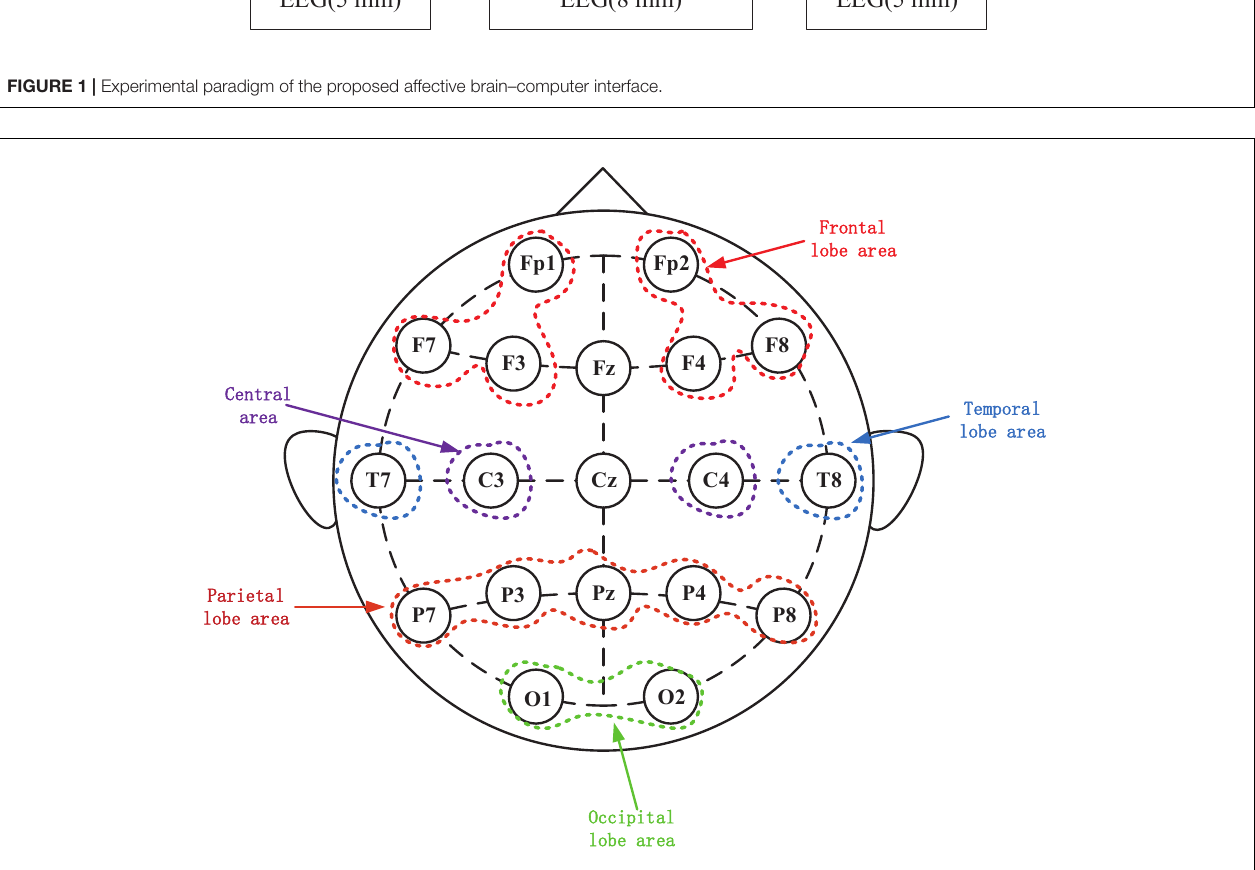
FIGURE 2 | Electroencephalography electrode placement based on the international 10–20 system. Scalp potential and reference point distribution of left and right frontal lobes.